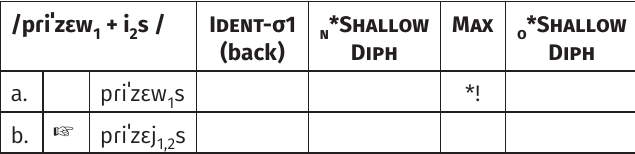
Table 4: A lax stem vowel allows the creation of a vertically optimal